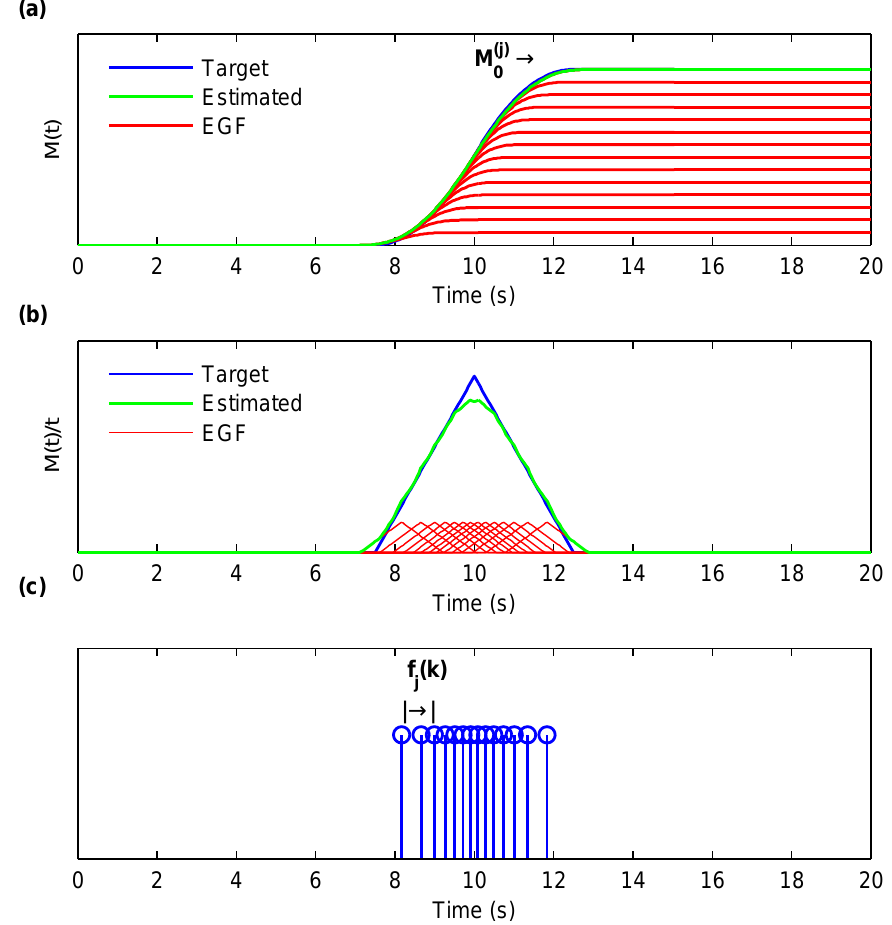
Figure 3. Time shifts used in this study. ( a ) moment (or slip) vs. time and approximation using multiple EGFs. ( b ) Moment-rate (or slip rate) vs. time and approximation using multiple EGFs. ( c ) Subfault j time shifts f j ( k ) used in the EGF